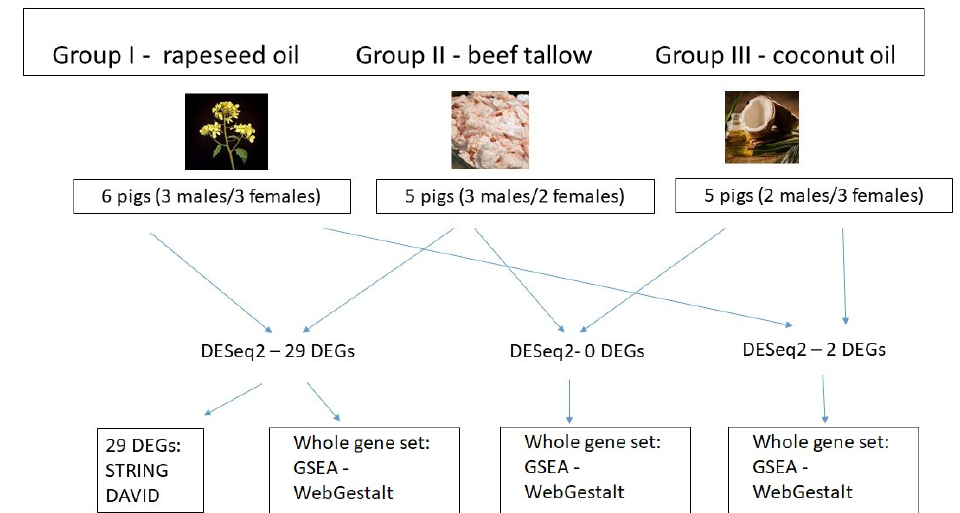
Figure 1. Scheme of the nutritional experiment and functional analyses performed in the study (DEGs: Differentially Expressed Genes, GSEA: Gen Set Enrichment Analysis).